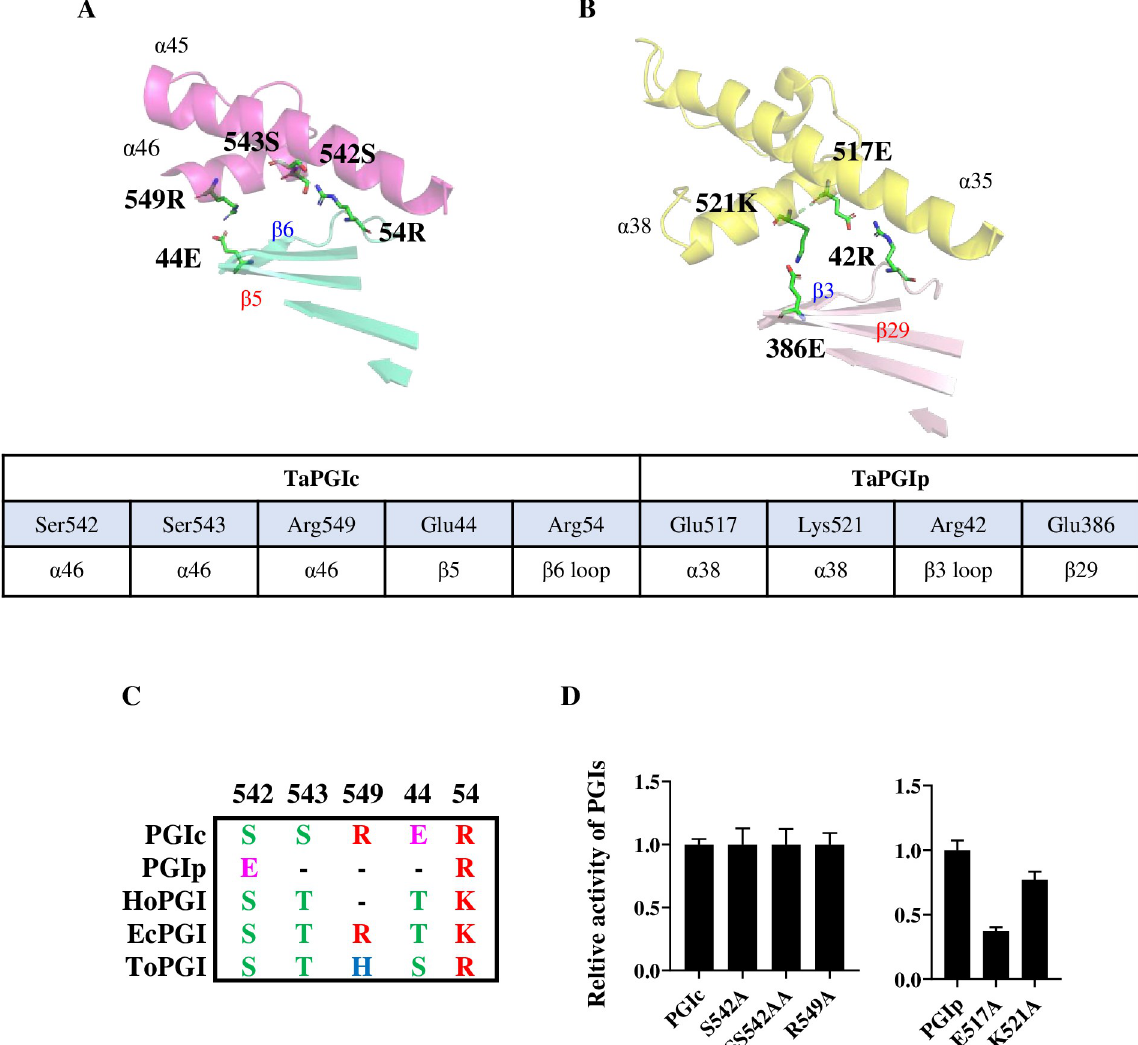
Fig 2. The C-terminal helix affected the quaternary structure and activity of TaPGIs. A. Residues affecting the quaternary structure and activity of TaPGIc at the CTD. Three residues (Ser542, Ser543, and Arg549) from the last C-terminal helix and 2 residues (Glu44 and Arg54) from β patch B and its extension loop in TaPGIc affect the quaternary structure and activity of TaPGIc. B. Residues affecting the quaternary structure and activity of TaPGIp at the CTD. Two residues (Glu517 and Lys521) from the last CTD and 2 residues (Arg42 and Glu386) from β patch B and its extension loop in TaPGIp affect the quaternary structure and activity of TaPGIp. C. Alignment of residues involved in the interaction described in B from different organisms. The residues Glu44, Arg54, Ser542, Ser543, and Arg549 of TaPGIc are not conserved among HoPGIc (from Homo sapiens ), EcPGIc (from Escherichia coli ), ToPGIc (from Toxoplasma gondii ), and TaPGIp. D. The relative activities of TaPGIs and their mutation variants. The sites mutated in TaPGIs are indicated as subscripts. n � 3. Error bars indicate the standard deviation.